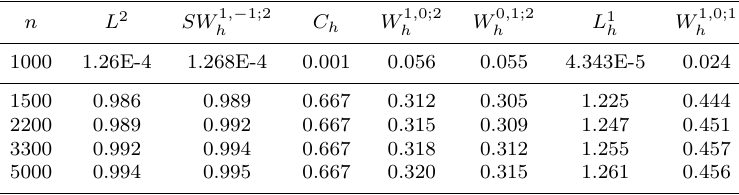
Table 19. Practical errors and error orders in Example C 1 / 2 , 0